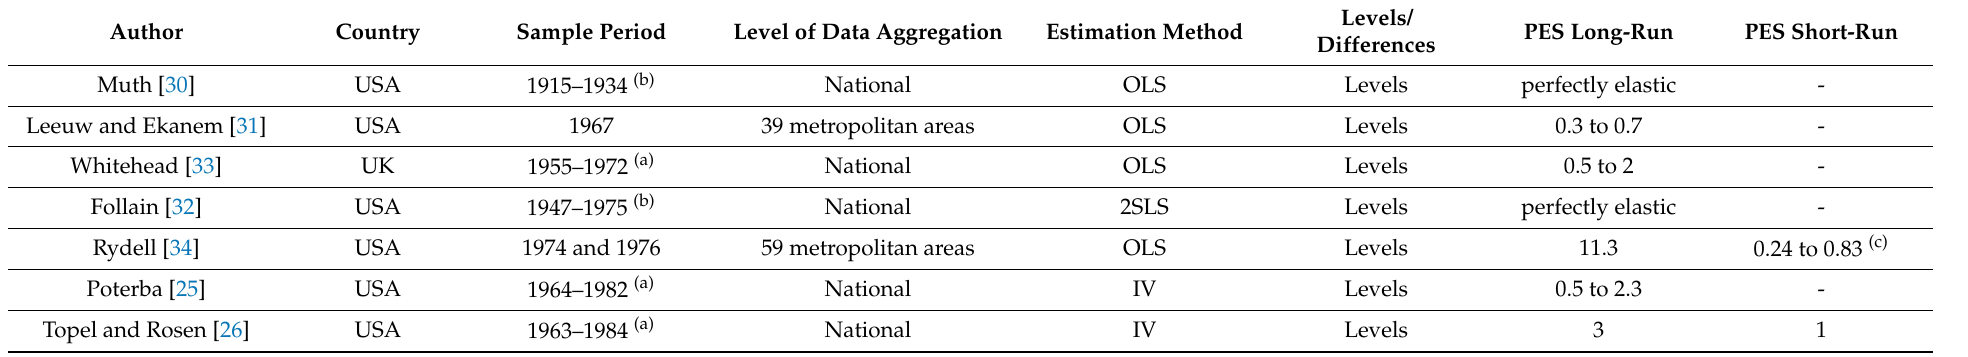
Table 1. First generation of literature in housing supply.